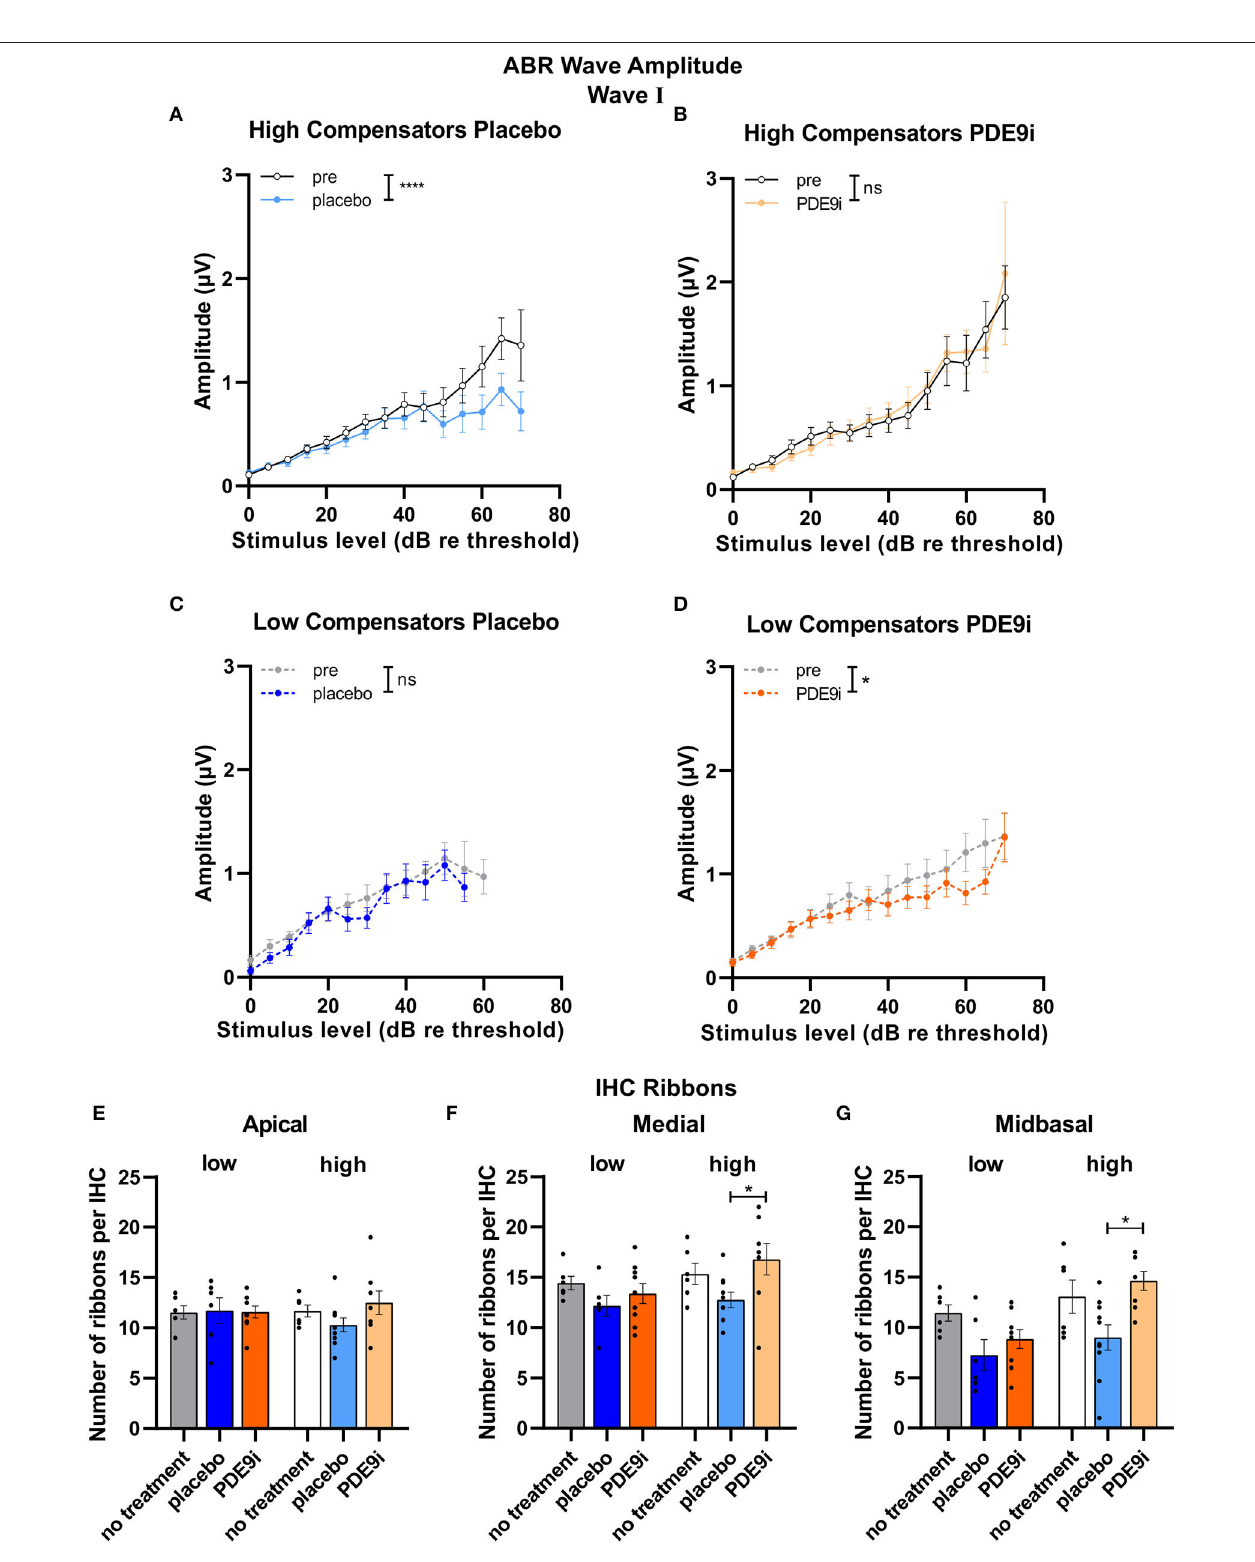
FIGURE 4 | ABR wave I and IHC ribbon numbers in high and low compensators before and after treatment with placebo or PDE9i. (A) High compensators showed a significant decrease in ABR wave I amplitude after treatment with placebo. (B) However, in high compensators treated with PDE9i, this decrease was not present. Low compensators showed no change in ABR wave I amplitude after treatment with (C) placebo (D) and a significantly decreased ABR wave I amplitude after